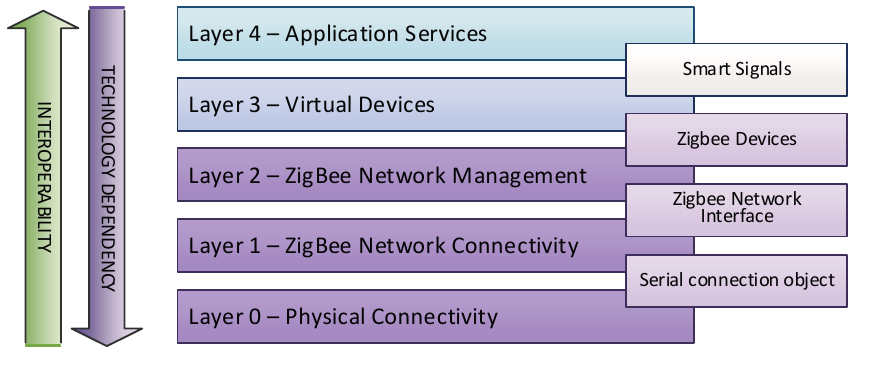
Figure 9. Gateway software